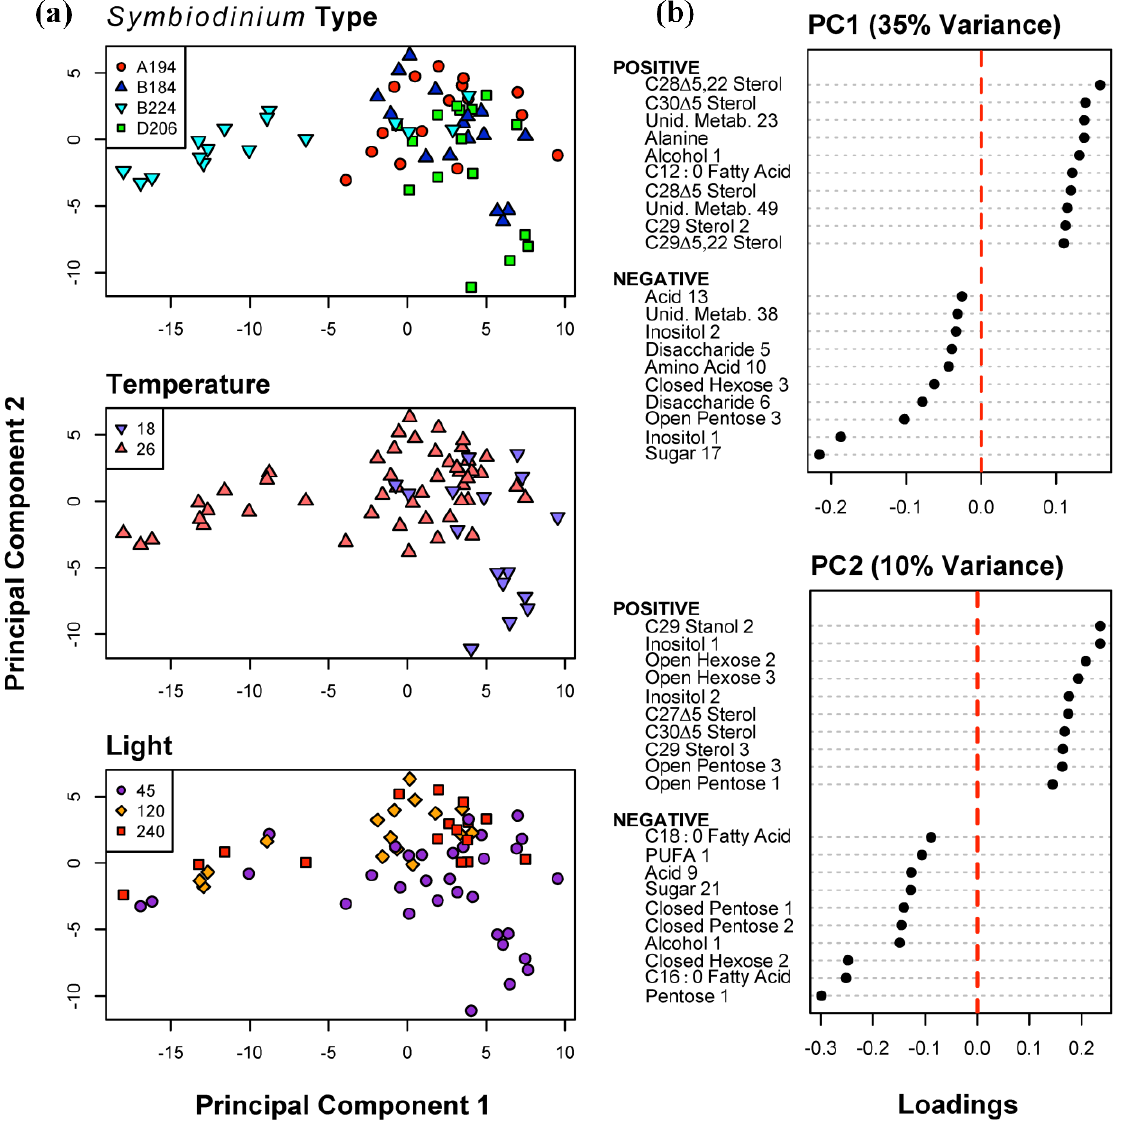
Figure 1. Principal Components Analysis of 155 metabolites for all 64 samples. ( a ) Distribution of sample scores on Principal Components (PC) 1 and 2, identified to Symbiodinium type, temperature (18 and 26 °C), and light intensity (45, 120 and 240 μ mol photons m −20 s −1 ) algae were cultured at; ( b ) The ten most positive and negative metabolite loadings on PC 1 and